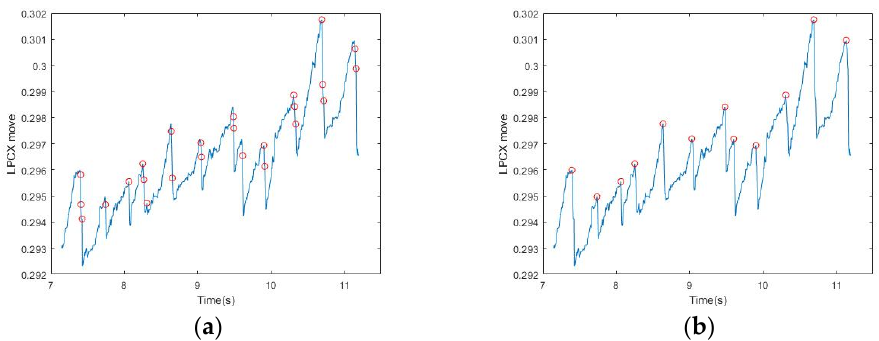
Figure 5. Results of iterative signal modification: ( a ) The starting point conforming to the length and slope in FP; ( b ) the maximum value obtained after comparing all starting points with their neighboring points and returning to the highest starting point. Table 3. Accuracy of iterative signal modification after the previous two steps (our method) for six subjects.